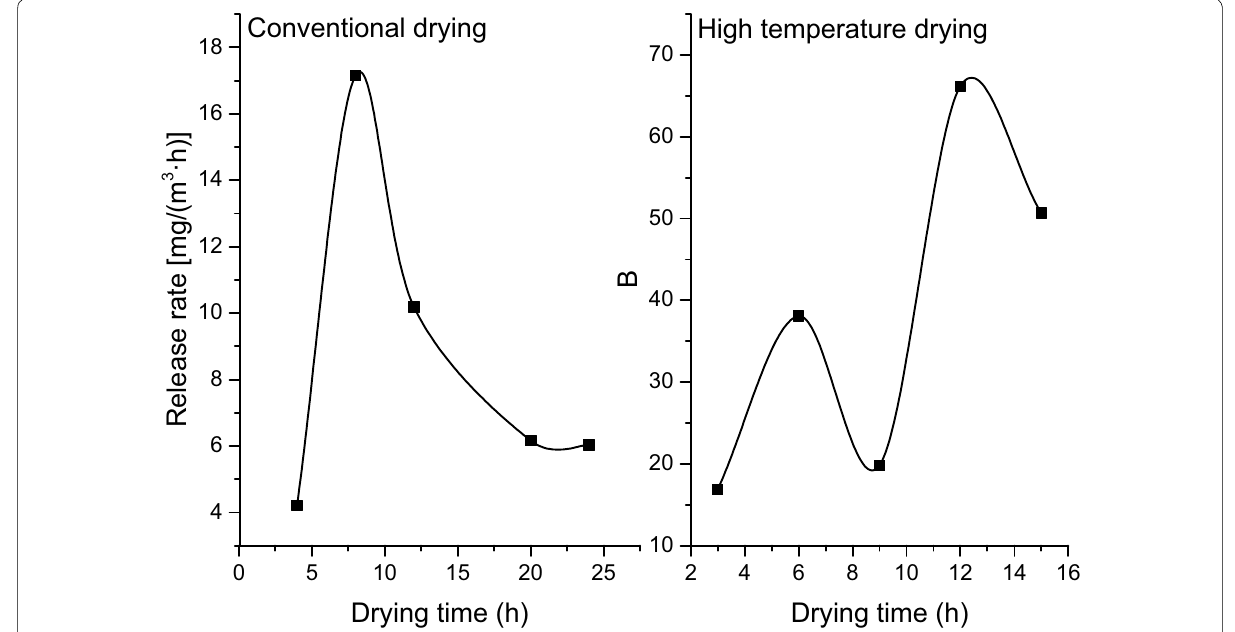
Fig. 8 Variation of release rate of TVOCs during conventional and high-temperature drying of the Russian P.